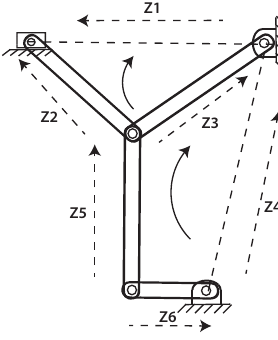
Figure 1. Two of the three available independent loops that are re- quired to analyze the mechanism are